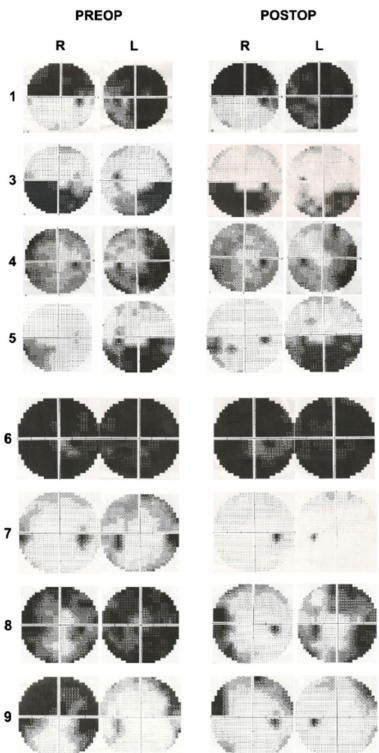
Figure 3. Preoperative and postoperative visual field examinations of